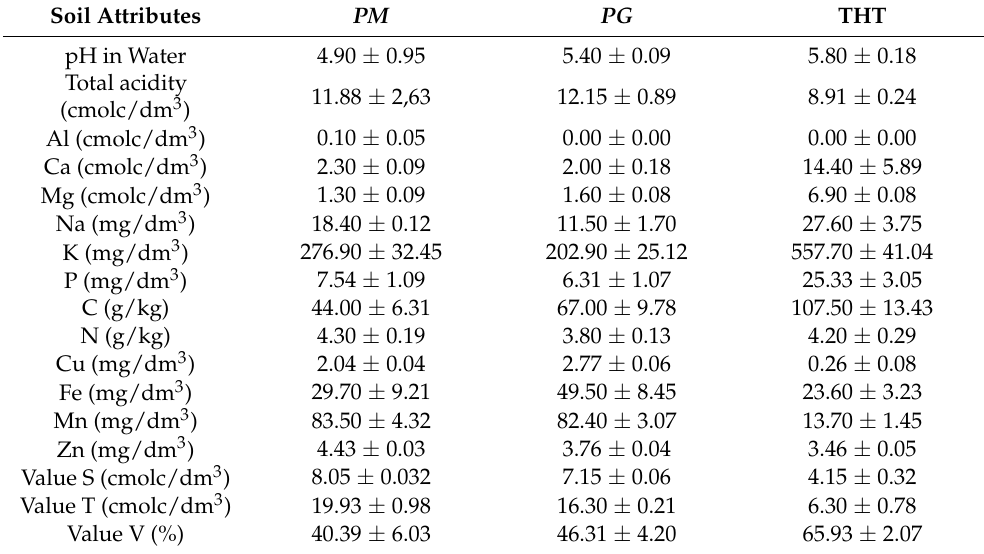
Table 2. Soil analysis results for Piper mollicumum (PM) and Piper gaudichaudianum (PG) in the Tijuca Forest/RJ and of the commercial substrate Tropstrato HT Hortaliças ® (THT). Soil Attributes PM